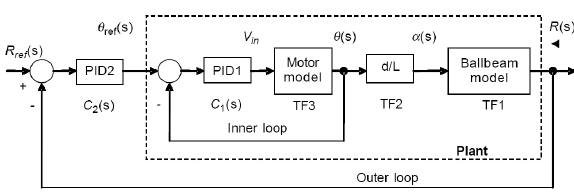
Figure 3: Design of a PID controller.